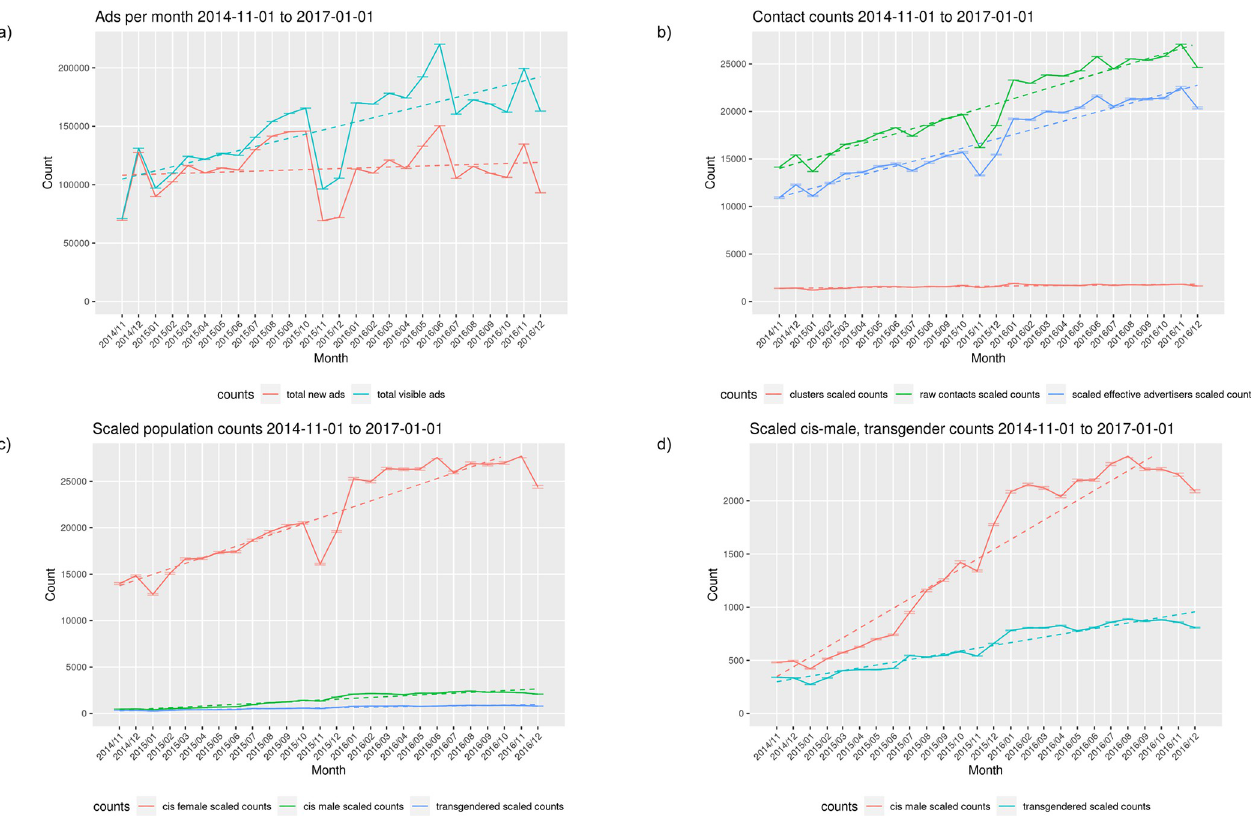
Fig 4. Canadian monthly counts for the period 2014-11-01 to 2016-12-31. a) ads downloaded; b) contacts, advertisers and clusters; c) estimated population by gender; d) male and transgendered population detail.